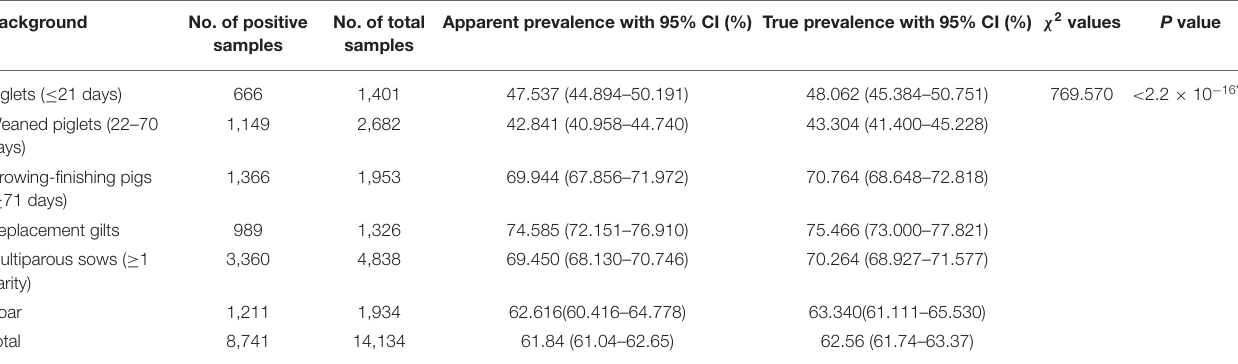
TABLE 2 | The apparent and true prevalence of PRRSV antibody with Pearson chi-square test in different stages of pigs.